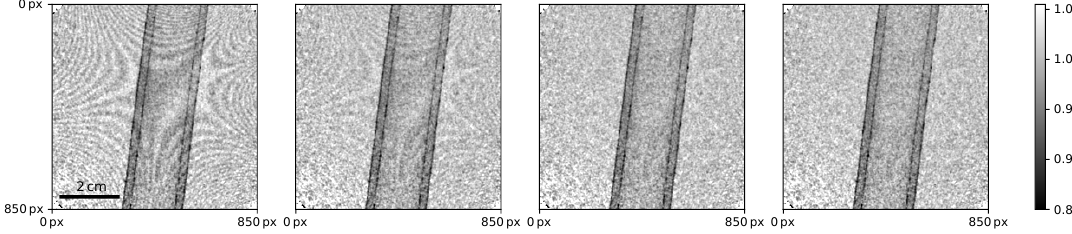
0px Figure 10. From left to right: Visibility images normalized to the respective empty beam images for 0 (regular analysis assuming perfect stepping), 1, 3 and 9 iterations of Algorithm 1 applied to the phase stepping series with and without sample, respectively. The grayscale window has been chosen to emphasize the Moiré